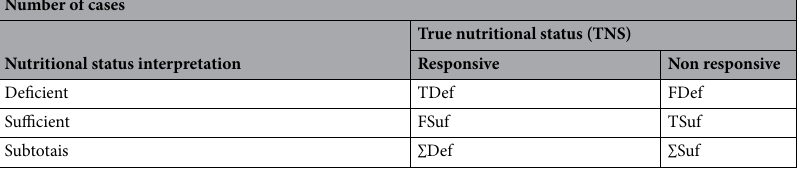
Table 4. Diagnosis of the nutritional status obtained by the interpretation method and the physiological true nutritional status (TNS) of the crop. TDef true deficiency, FDef false deficiency, FSuf false sufficiency, TSuf true sufficiency, ∑Def sum of deficiency, ∑Suf sum of